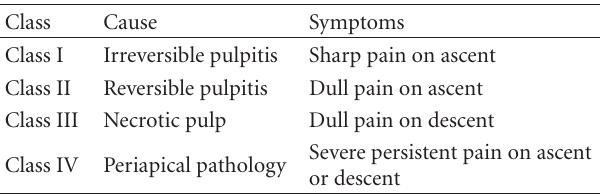
Table 1: Classification of barodontalgia.